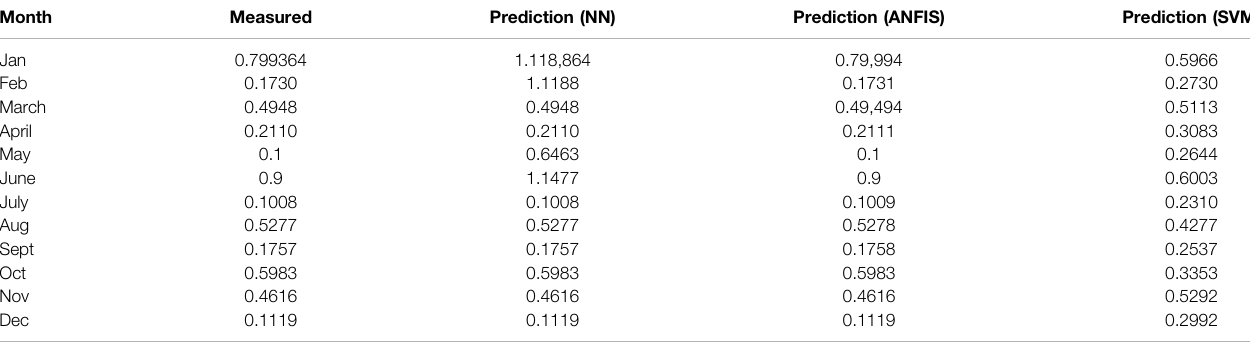
TABLE 2 | Relative outcome with ANN, ANFIS, and SVM algorithms. Model comparison of different regions. Month Measured